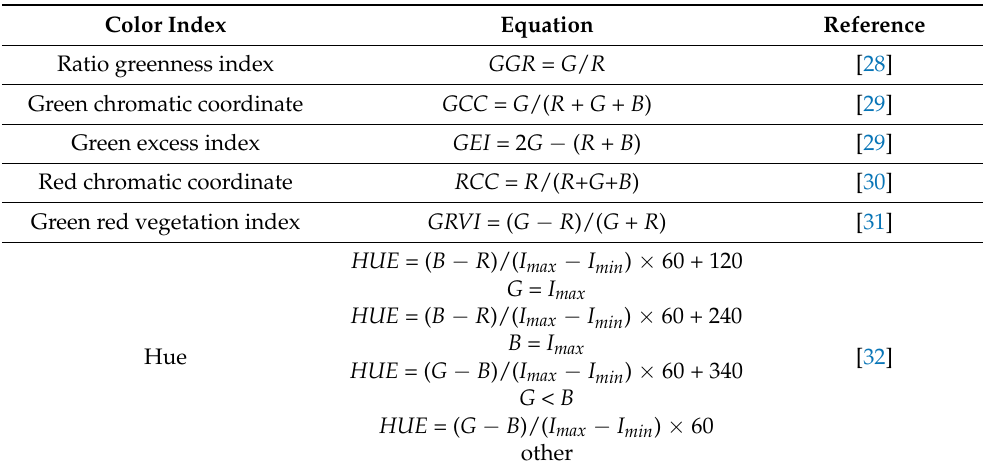
Table 2. Equations of color indices